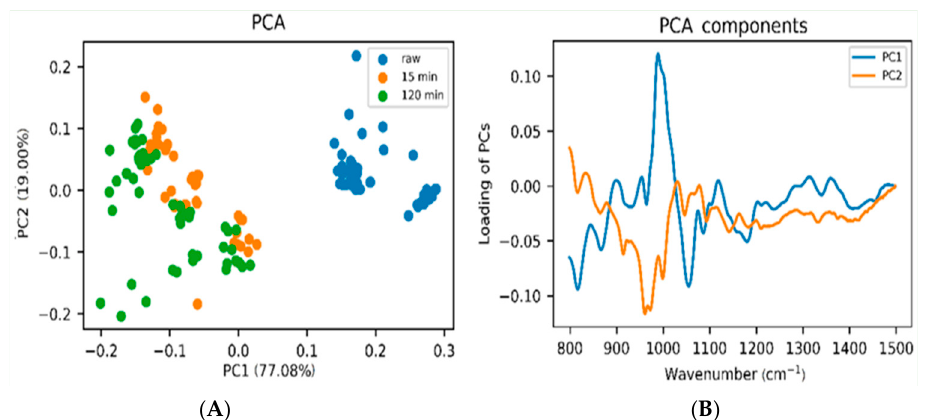
Figure 4. Based on ATR-FTIR data ( A ) PCA score plot and ( B ) loading plot for raw and thermally treated eucalyptus honey samples. Adopted from [215].